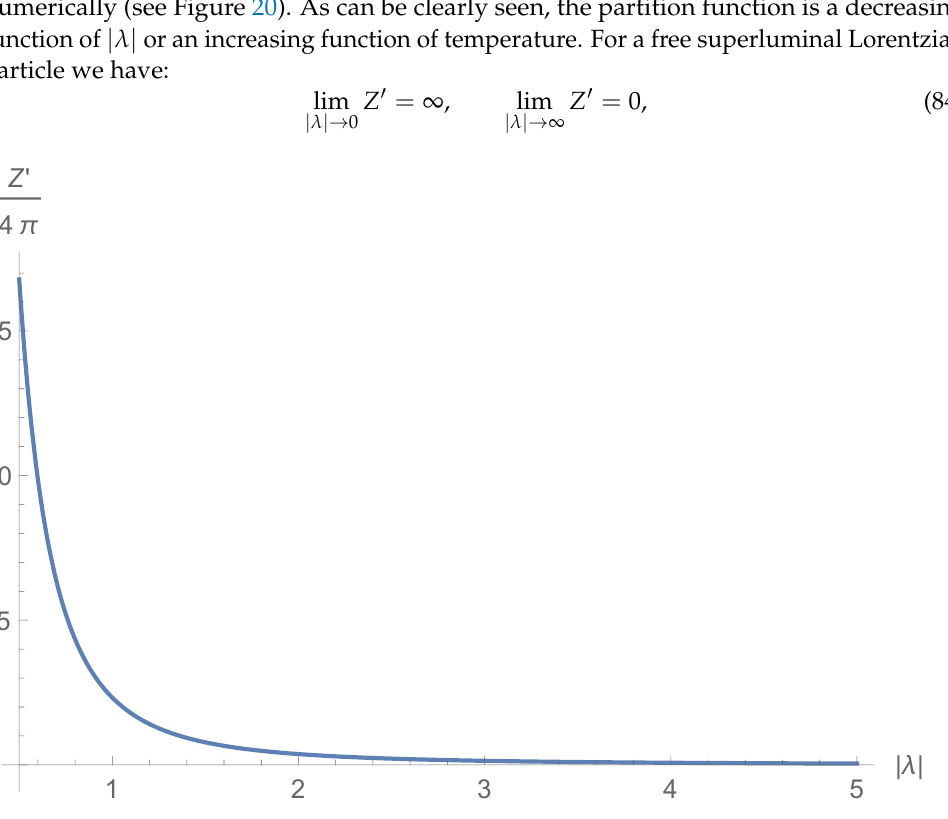
Figure 20. Partition function for a free superluminal Lorentzian